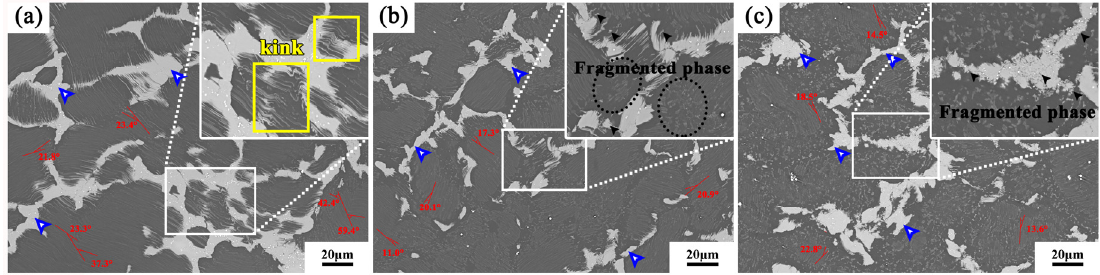
Figure 4. Backscattered electron (BSE) images of the alloys under different MDFed passes: ( a ) 1 pass; ( b ) 2 passes; ( c ) 3 passes.